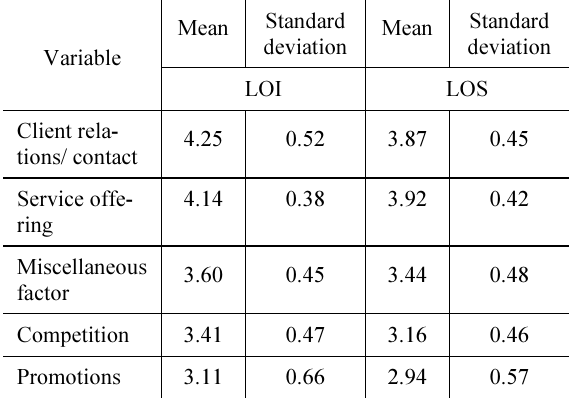
Table 5. Marketing strategies: ranking of